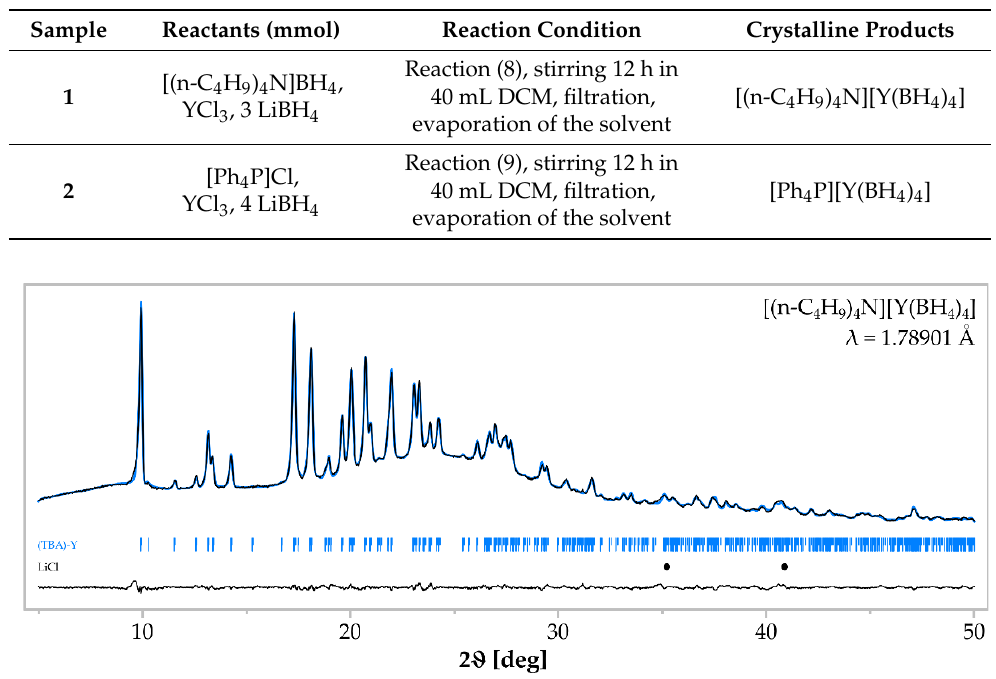
Figure 1. Rietveld analysis of the product sample 1 comprising [(n-C 4 H 9 ) 4 N][Y(BH 4 ) 4 ]. The black profile represents experimental data; blue line — calculated profile. Positions of Bragg reflections for [(n-C 4 H 9 ) 4 N][Y(BH 4 ) 4 ] (blue marks) and LiCl (black dots, not refined) are shown below. A difference curve (between the experimental and calculated profiles) is plotted at the bottom.